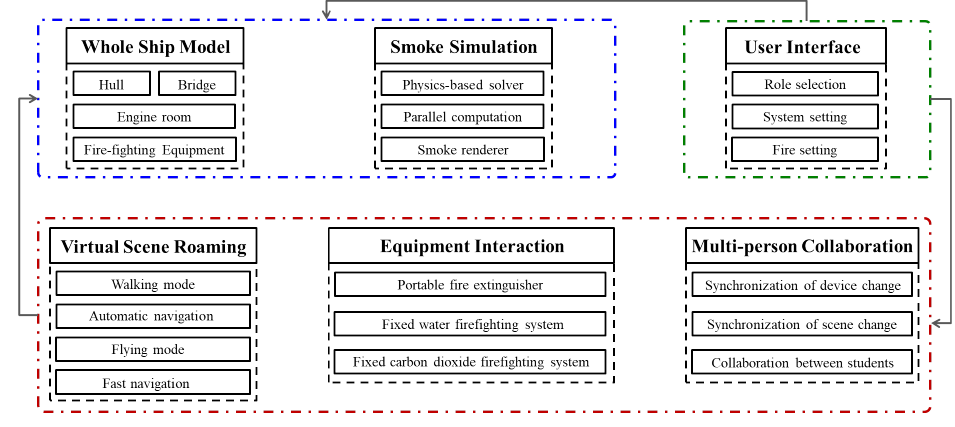
Figure 1. System